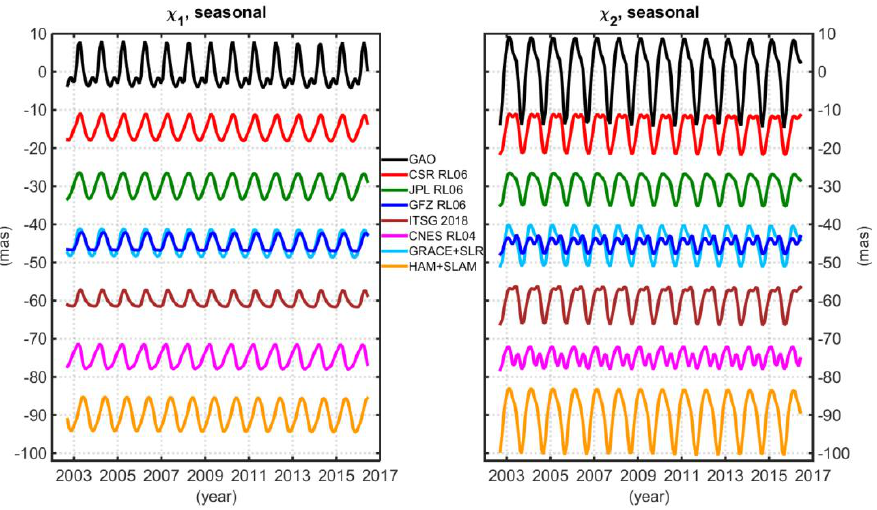
Figure 7. Seasonal changes (sum of annual, semi-annual, and ter-annual oscillations, after removing linear trends) in χ 1 and χ 2 components of GAO, GSMAM, GRACE + SLR, and HAM + SLAM.